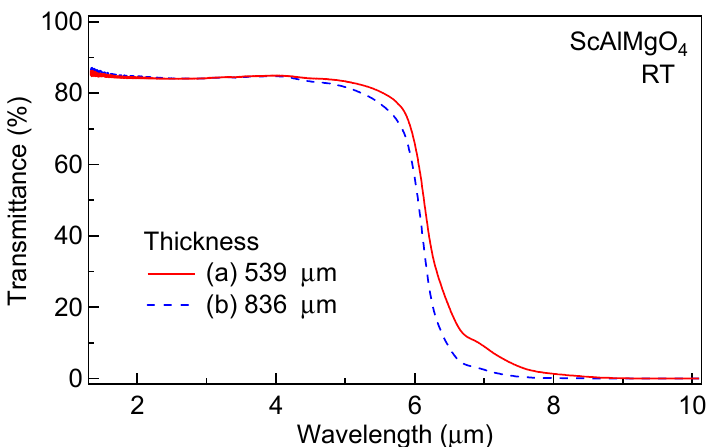
Figure 10. FT-IR transmission spectra of SCAM substrates with thicknesses of (a) 539 µm and (b) 836 µm measured at room temperature.